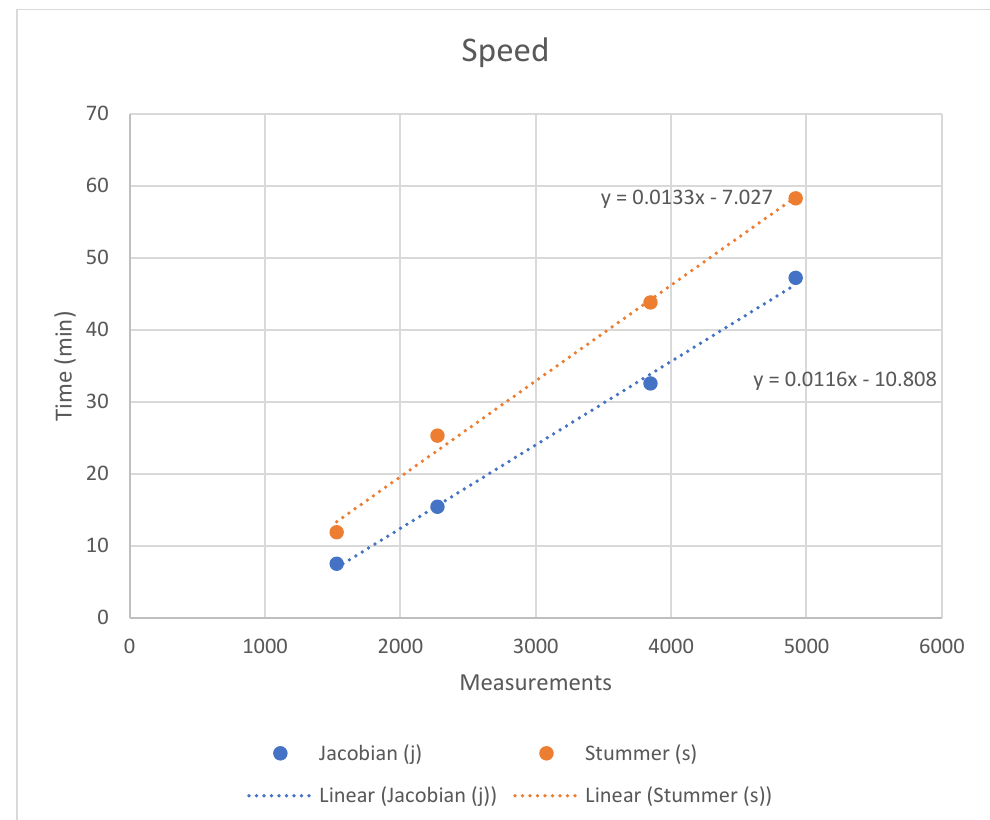
Figure 11. Speed comparison between Jacobian and Stummer optimization approach.